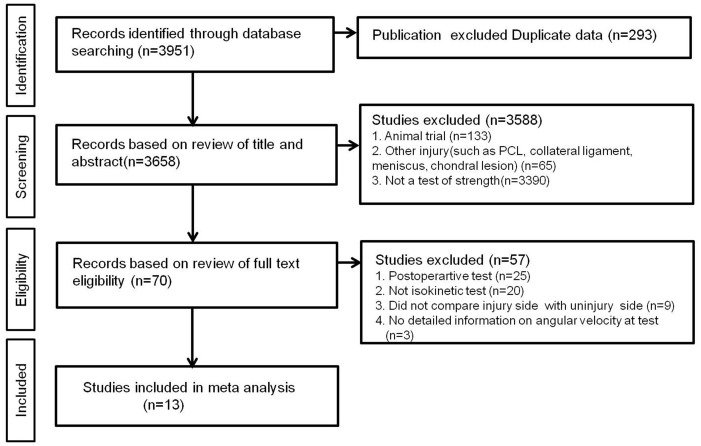
PRISMA (Preferred Reporting Items for Systematic reviews and Meta-analyses) flow diagram of the identification and selection of the studies included in this meta-analysis.